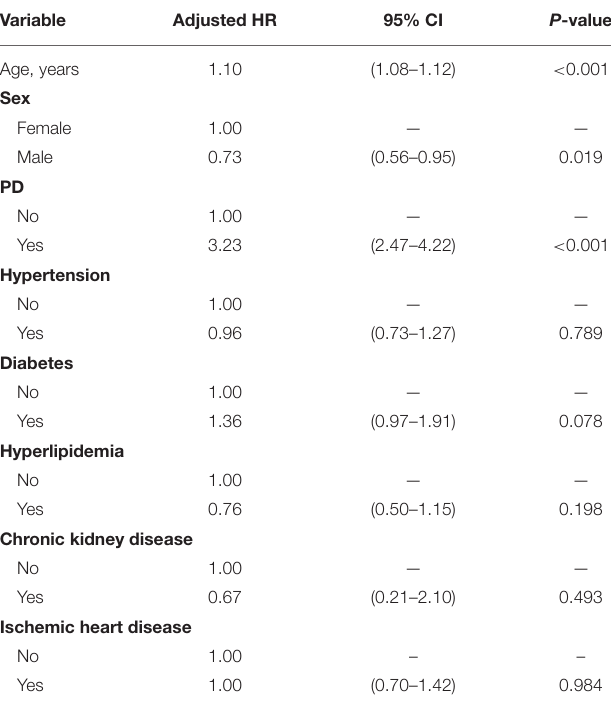
TABLE 3 | Hazard ratio associated with dementia in Cox’s regression analysis, as stratified by confounders.